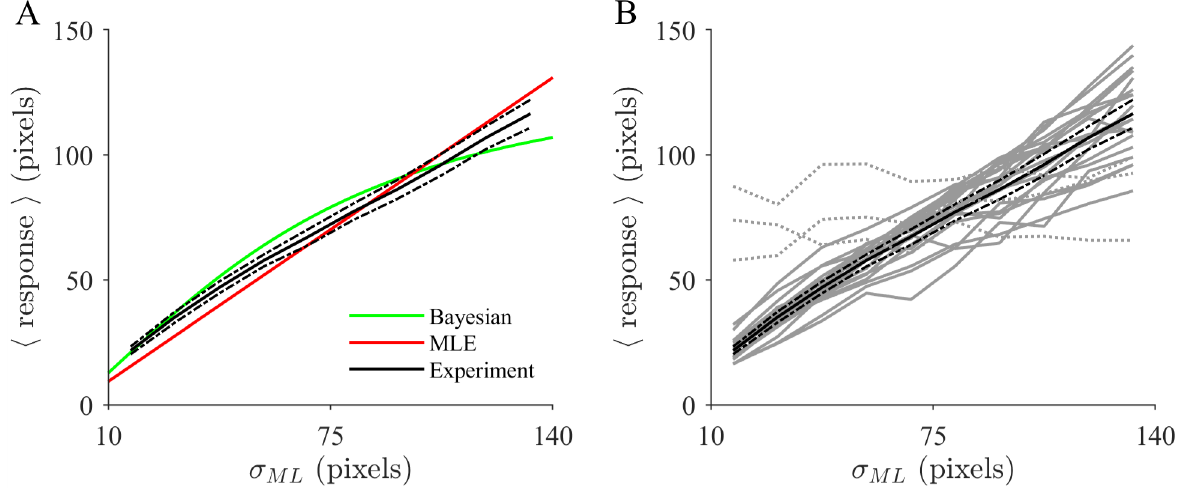
Fig 3. Human behavior closely tracks trial-by-trial uncertainty of future events. (A) Mean responses across participants plotted as a function of the MLE of the sample, σ ML ( d ) ,in ten equally spaced bins (black; error bars, 95% CI). Basing behavior on a Gaussian estimated by ML (red, N(x|0, σ ML ( d )) )results in responses proportional to the estimate. The prior distribution that is assumed by the devised Bayesian benchmark model (green) biases responses towards intermediate values (see Methods). (B) Individual response curves of all 23 participants tested (gray lines). Three participants displaying poor compliance with the instructed task (dotted) were excluded from further analysis. The average across the remaining participants is superimposed (black).